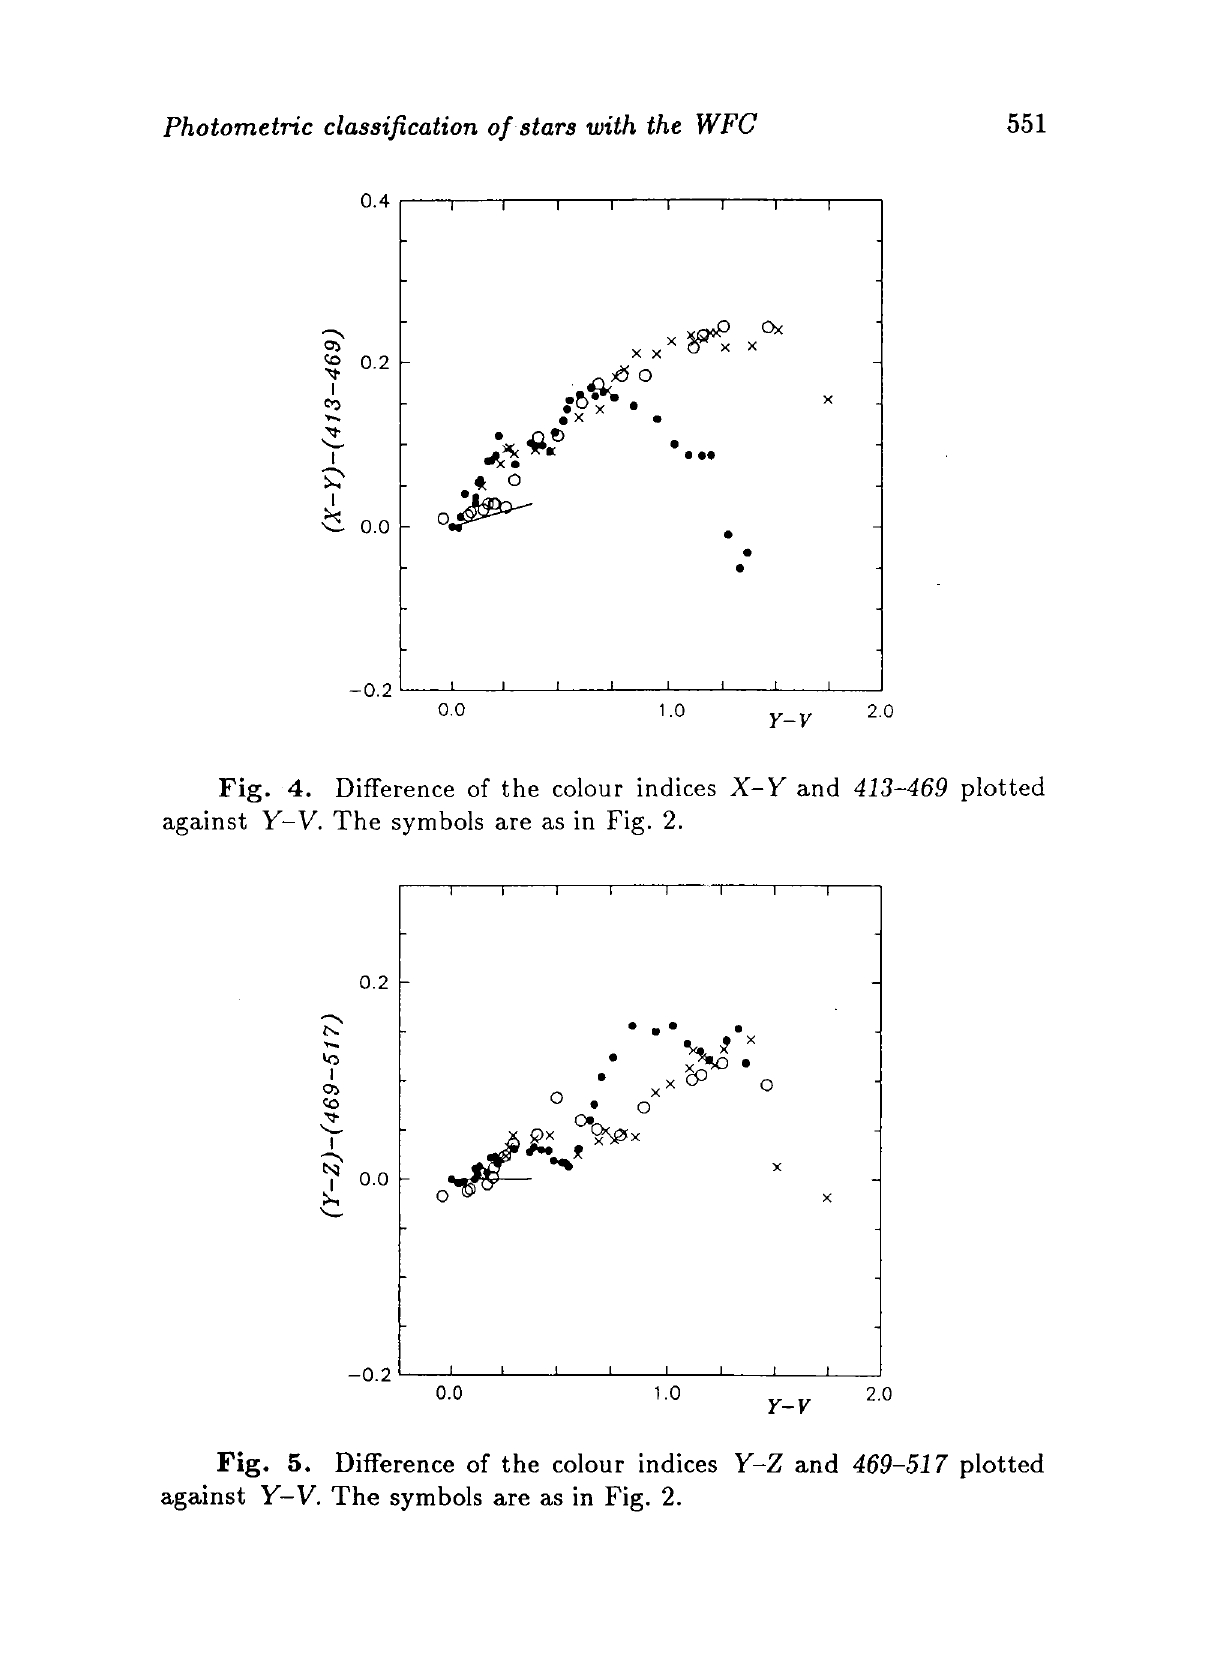
Fig. 5. Difference of the colour indices Y-Z and 469-517 plotted against Y-V. The symbols are as in Fig.